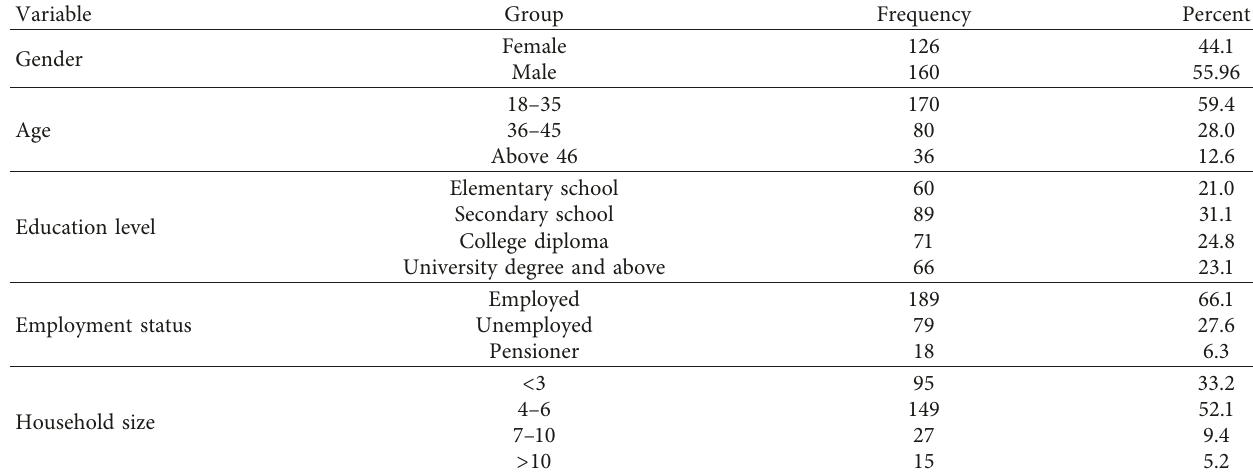
Table 2: Gender, age, education, employment status, and household size of the respondents.